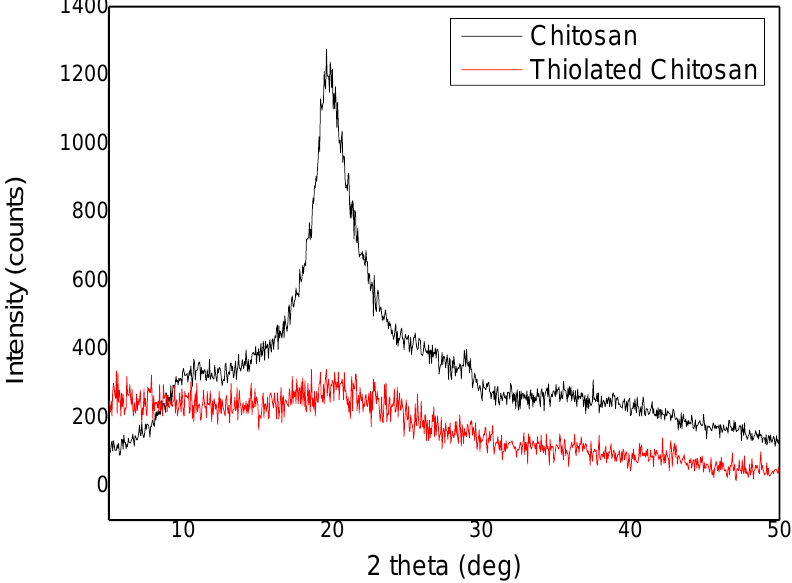
Figure 2. XRD patterns of chitosan and thiolated chitosan.